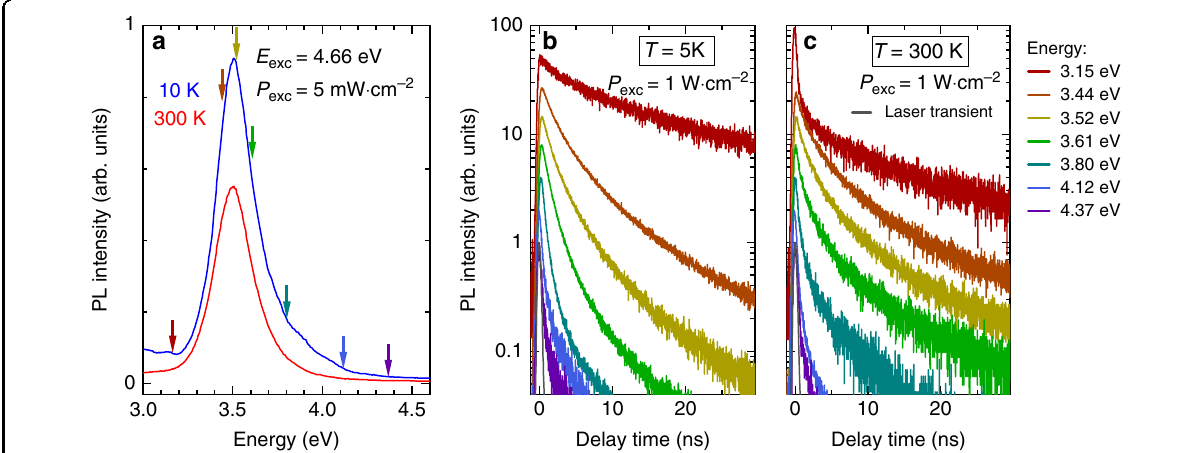
Fig. 7 Time-resolved photoluminescence from a QD ensemble. a Temperature dependence of the QD ensemble photoluminescence. The arrows mark the energies at which the TRPL transients shown in b and c are measured. The excitation power density is chosen low enough to ensure that most of the signal stems from excitonic recombination. Time-resolved photoluminescence transients measured at 5 K b . and 300 K c . are displayed. The laser transient is also given (grey